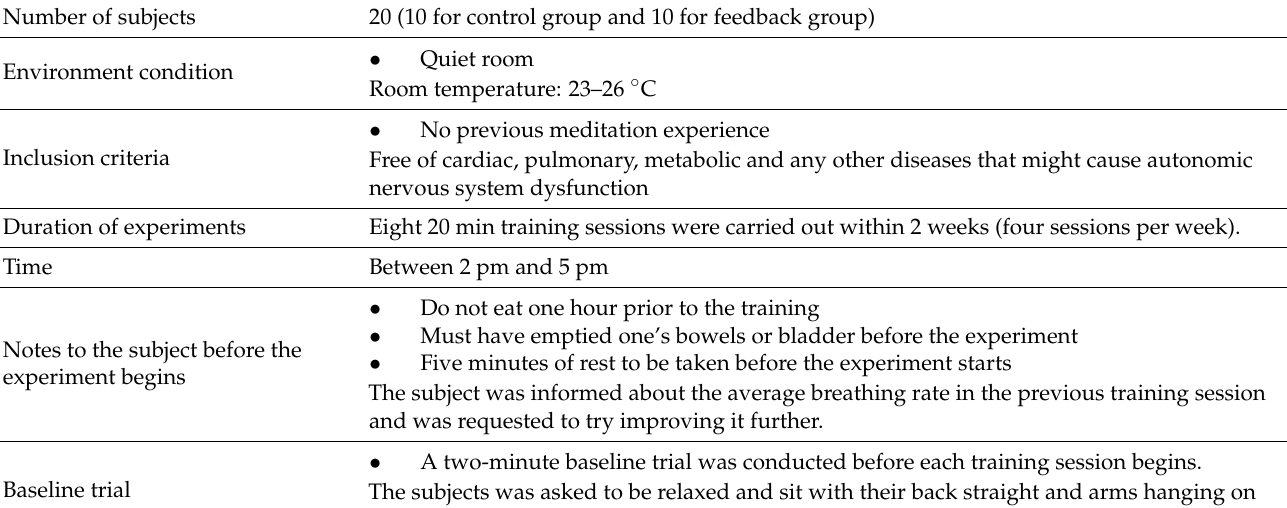
Table 2. Details of experiment